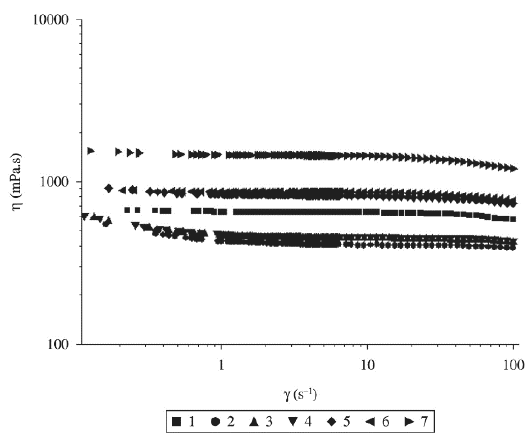
Figure 5. Viscosity as a function of shear rate of the solutions with different concentrations of acetic acid.